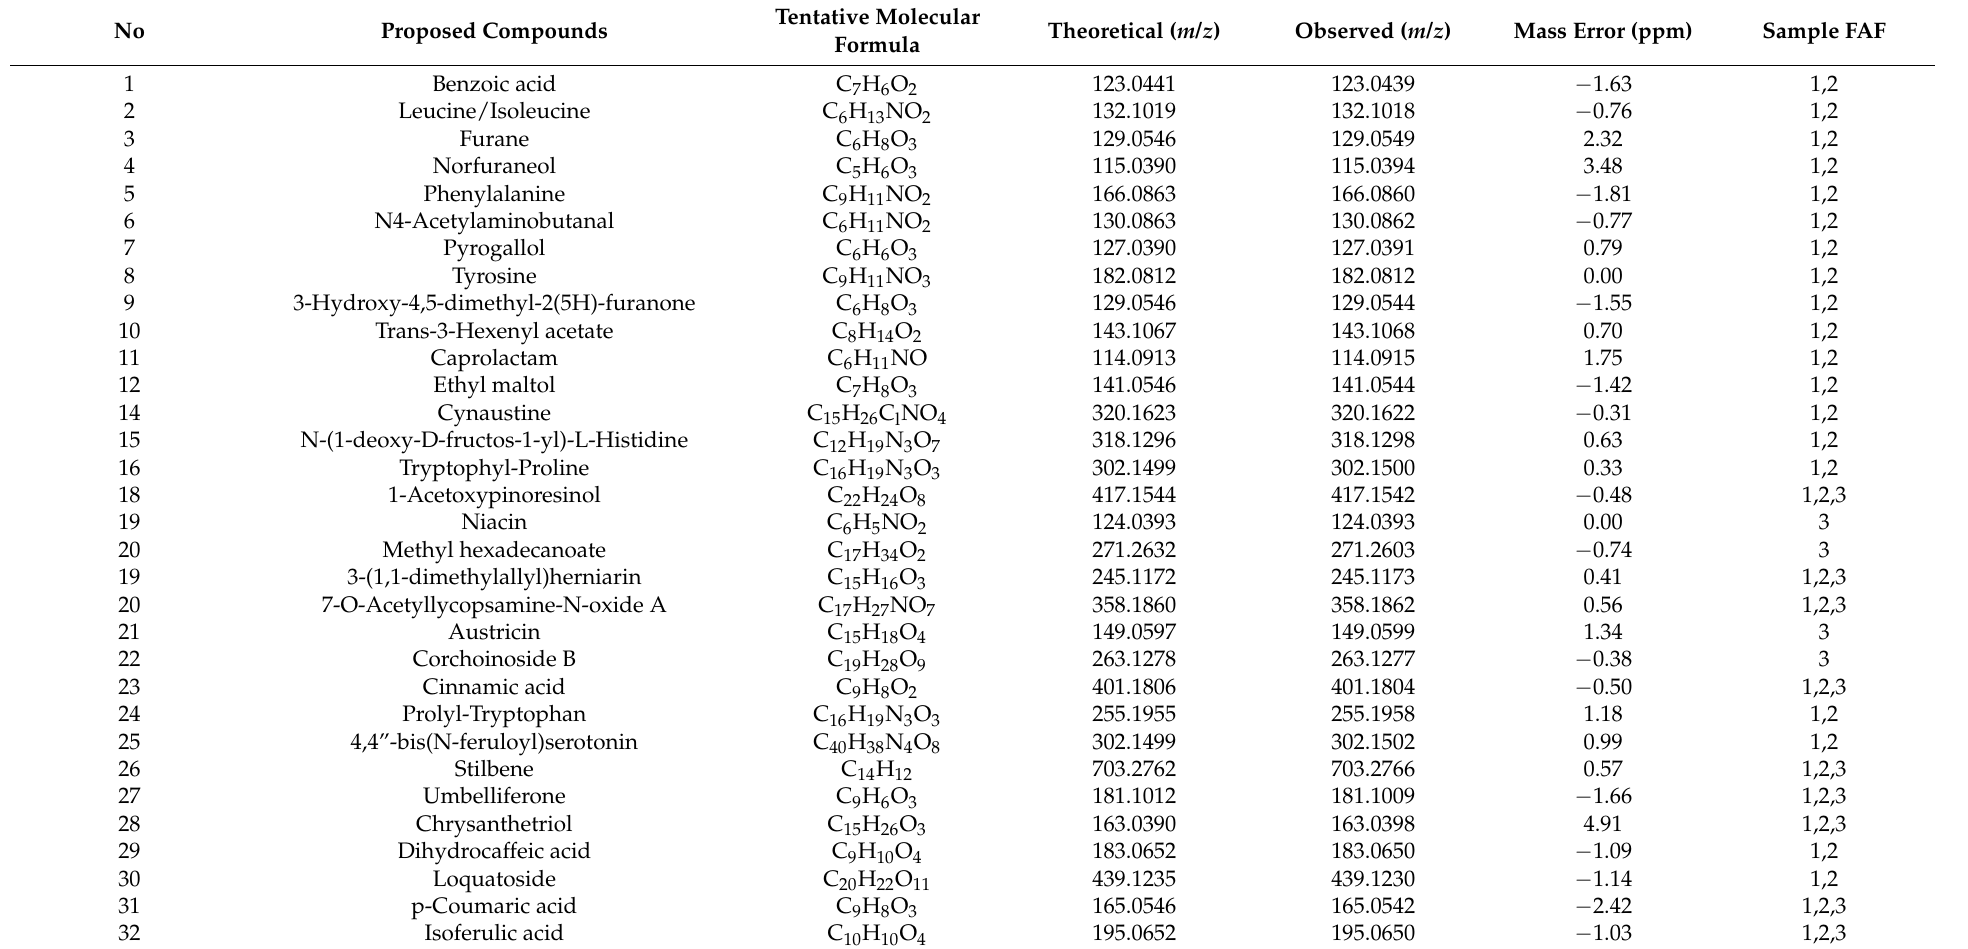
Table 3. Separated phytocomponents from the ethanol extracts of Matricaria recutita white ray floret supercritical fluid